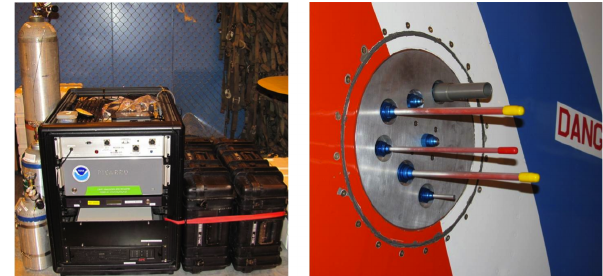
Fig. 2. NOAA equipment pallet for USCG C-130: three reference gas cylinders, instrument rack, and two Programmable Flask Pack- ages (PFPs) (left). Window replacement inlet plate (external view)